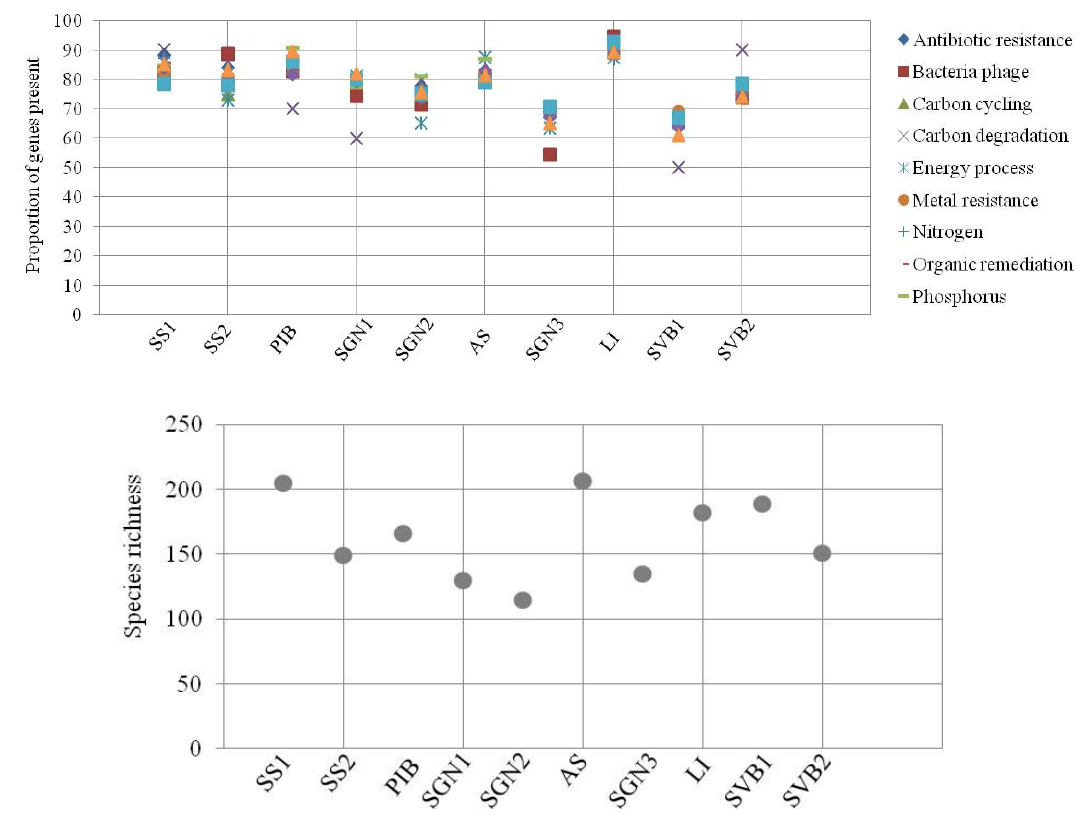
Figure 1. Distribution of functional groups as defined in He et al. 2010 [20] (upper panel) and species richness (lower panel) across sites. Antarctic: SS: South Sandwich; PIB: Pine Island Bay; SGN: South Georgia North; AS: Amundsen Sea; LI: Livingston Island. Arctic: SVB: Svalbard. The data are presented as standardized for the number of functional genes per functional group included in the microarray (as the proportion from all the genes included that is present at each site).